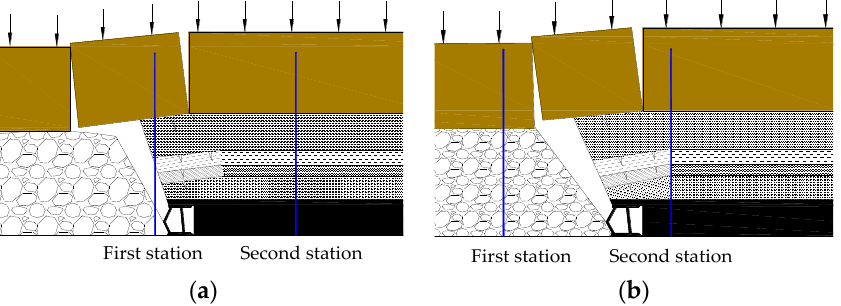
Figure 9. Sketch-profiles showing roof structure at different period weighting: ( a ) after the first period weighting; ( b ) after the second period weighting.